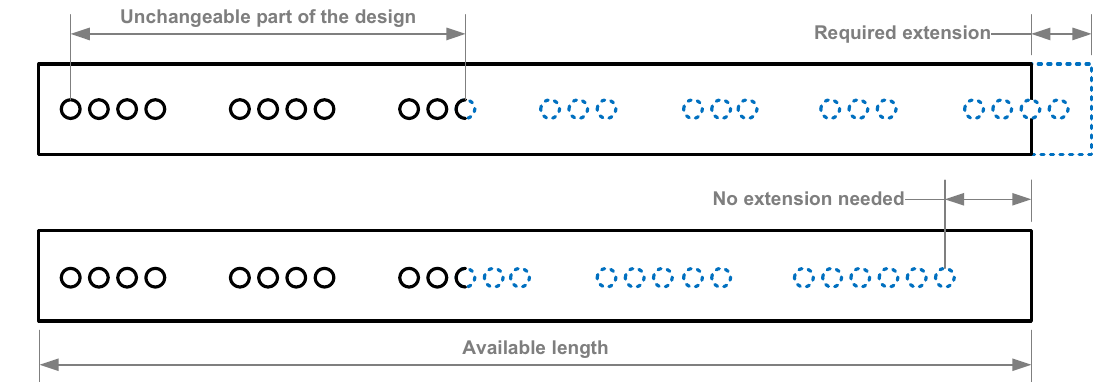
Fig. 2 Illustration of situations where configurations of wells may (top) or may not (bottom) need a landfilling